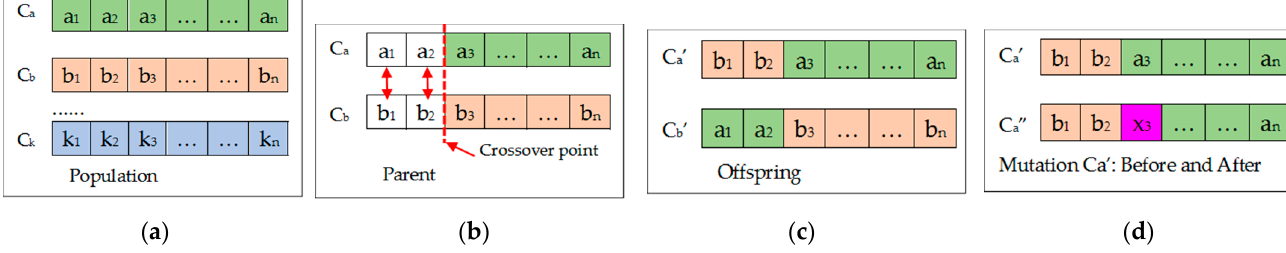
Figure 3. The approach and steps of the genetic algorithm (source: adapted from Mallawaarachchi [44]): ( a ) the relationship of population, chromosomes, and genes (Population = ∑ Cj; C a . . . C k are the chromosomes in a population, j is the ordinal number of the chromosome; a i , . . . k n are the genes in the chromosomes, i is the ordinal number of the gene); ( b ) crossover point of parents’ gene; ( c ) producing new offspring after crossover; ( d ) selecting better offspring to mutation, and the difference of before and after mutation.